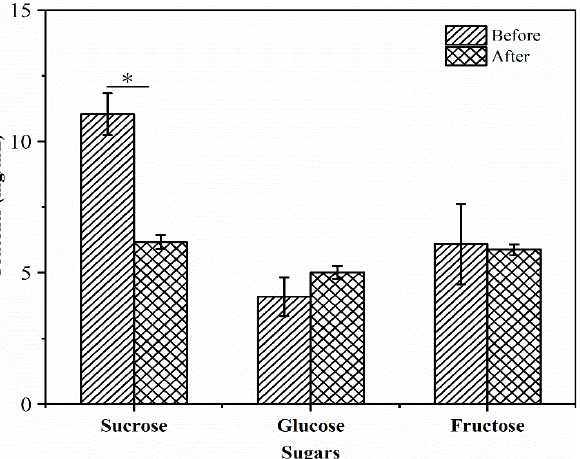
Figure 3. Changes in the content of sugars before and after fermentation of the R–B mixed juice with L. plantarum TUST-232. The contents of sugars, including sucrose, glucose, and fructose, were measured. The error bars indicate means ± SD ( n = 3); the differences between groups were analyzed by a two-tailed paired Student’s t- test; * p < 0.05.